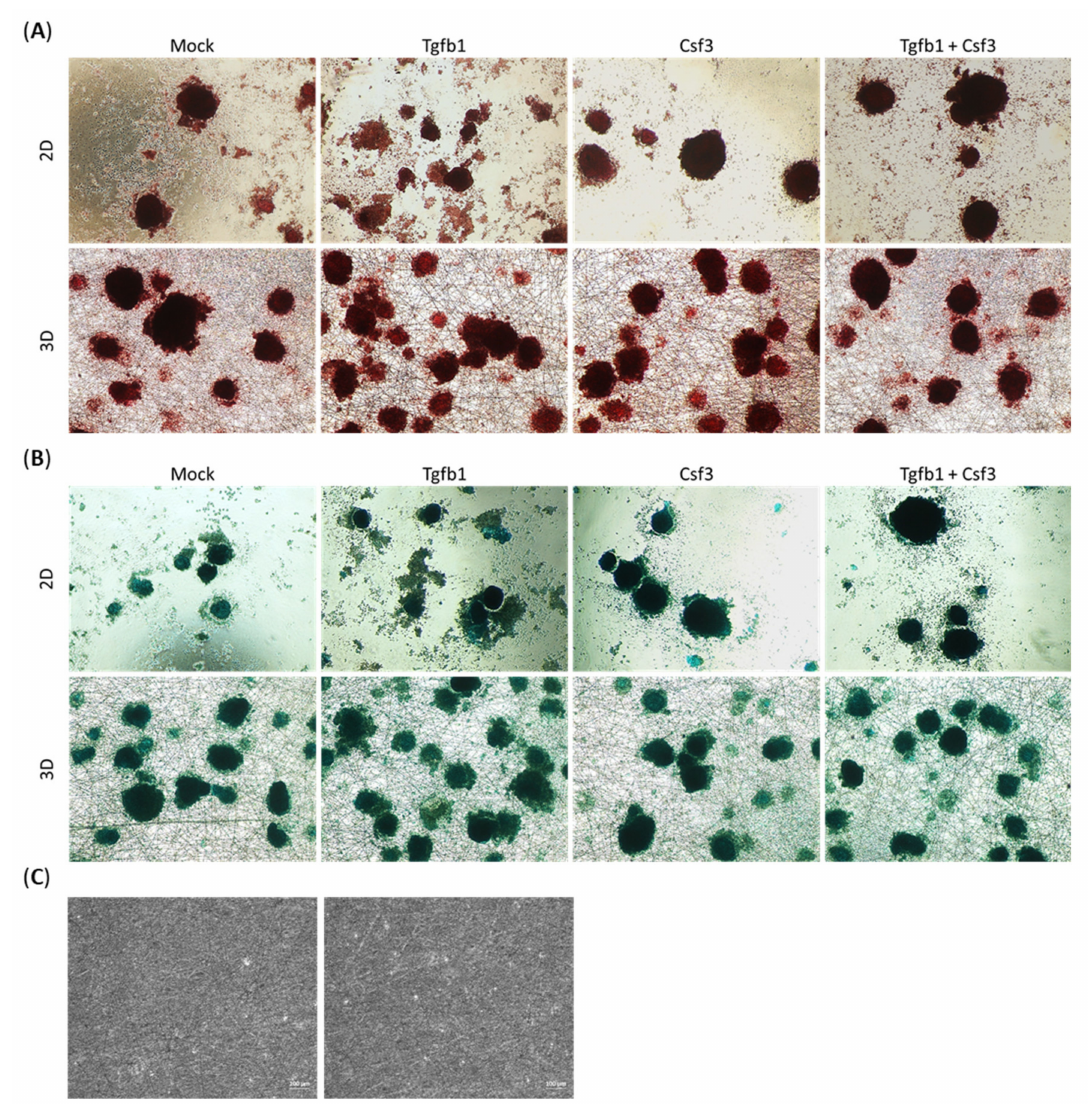
Figure 3. Representative images of safranin O and alcian blue stained chondrogenic aggregates at the end of stage 2. ( A ) Safranin O staining to detect the expression of acidic proteoglycan. ( B ) Alcian blue staining to localize the expression of acid mucosubstances and acetic mucin. ( C ) The photos of 3D scaffold which stained with safrain O (left panel) and alcian blue (right panel). Images were captured under phase contrast microscope, at 100 ×